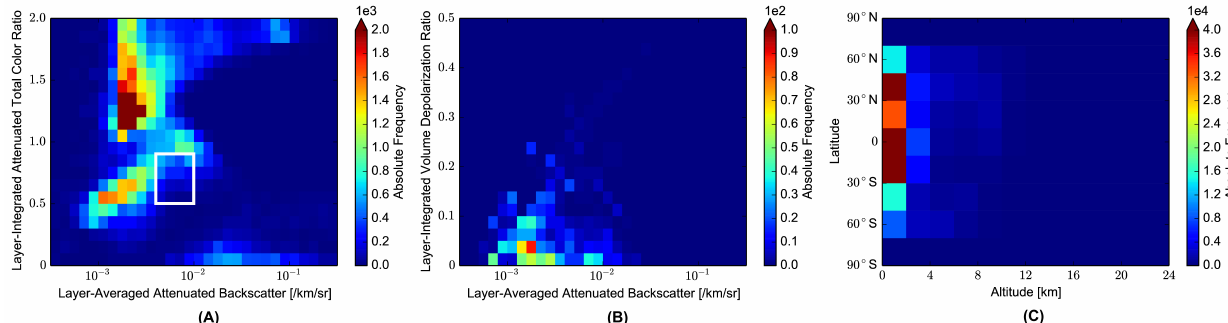
Figure 6. Occurrence frequencies of NCR features north of 70 ◦ S with filters applied in the 2D space of dimensions CR-AB ( A ); DR-AB ( B ); and latitude–altitude ( C